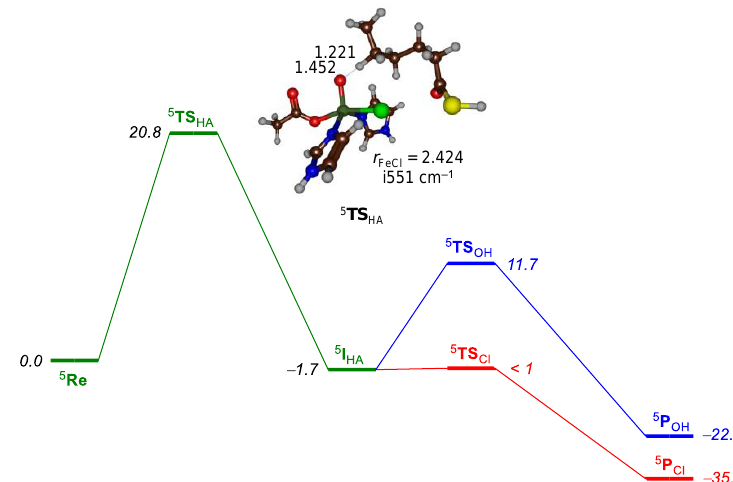
Figure 11. Quantum mechanics/molecular mechanics (QM/MM)-calculated reaction mechanism of substrate chlorination and hydroxylation by an iron(IV)-oxo oxidant in HctB. Energies (in kcal mol − 1 ) obtained at UB3LYP/SV(P) with zero-point corrections included. Hydrogen atom abstraction transition state with bond lengths in angstroms and the imaginary frequency in wave numbers.